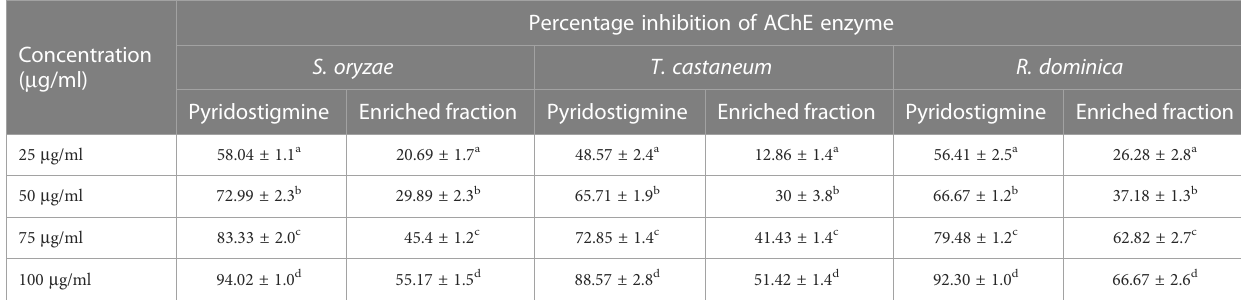
TABLE 2 Percentage inhibition of enriched fraction on AChE enzyme activity.